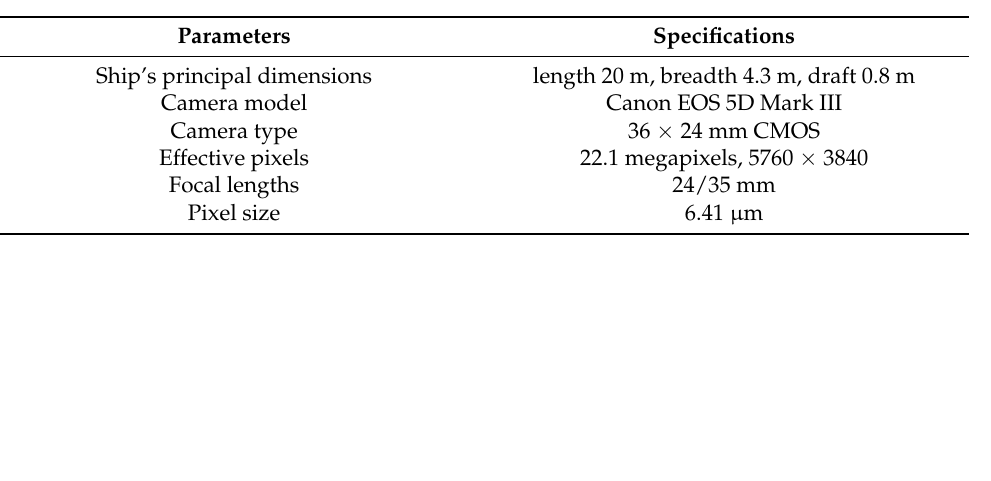
Table 1. Main technical parameters of the ship and